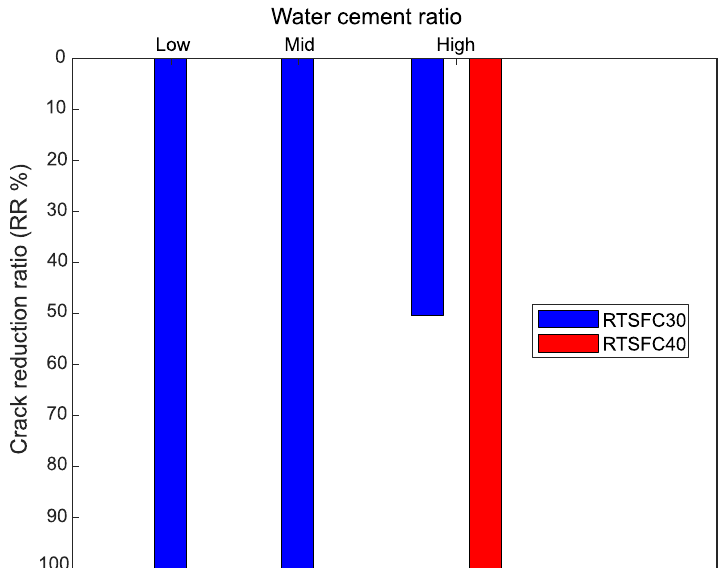
Figure 18. Crack reduction ratio for all water cement ratio.